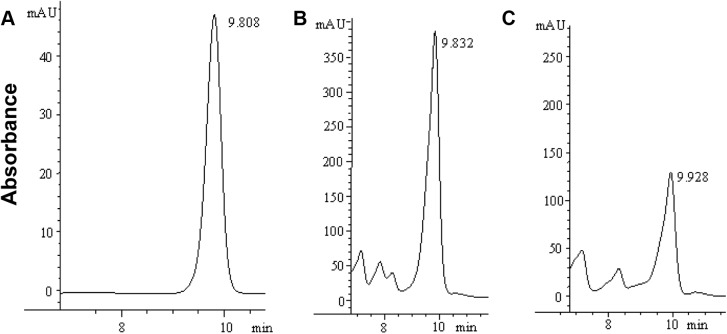
GacA positively controlled IAA biosynthesis.HPLC analysis was performed to detect IAA production with 50 μg/ ml synthetic IAA (A) as a standard between the wild type G5 (B) and the gacA mutant G5-6 (C). 20 μl of each sample were loaded and eluted isocratically at a 1 ml/ min flow rate.